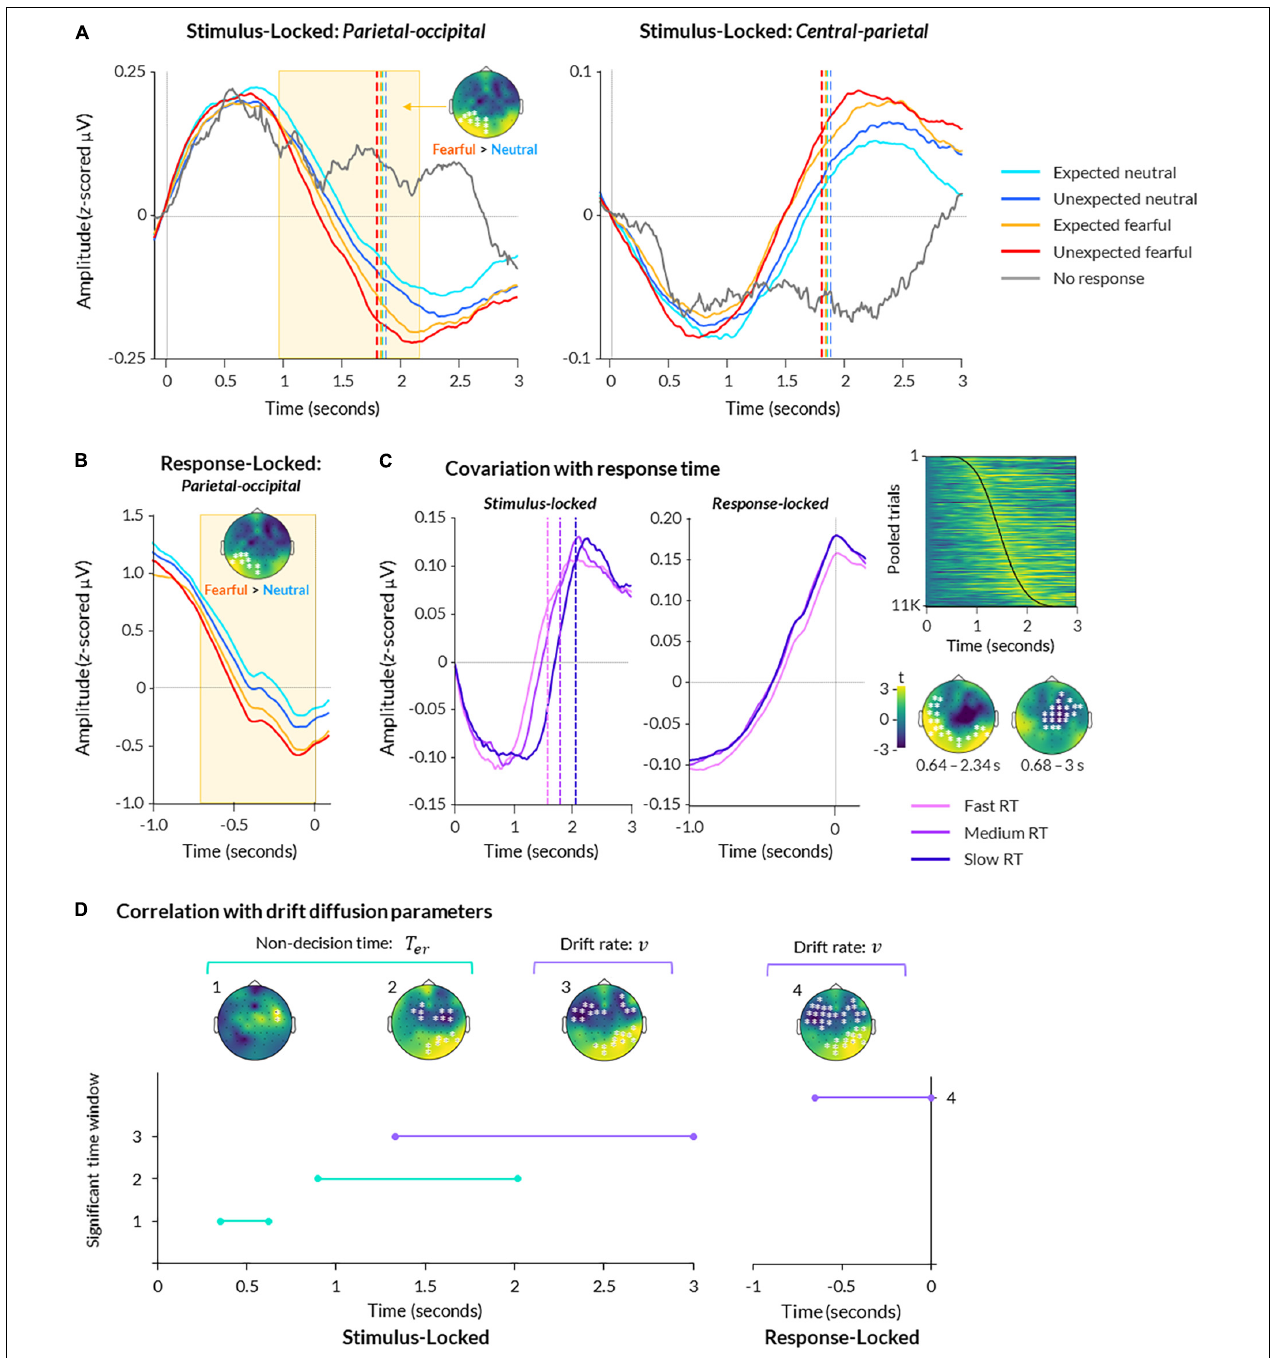
FIGURE 3 | Electroencephalography (EEG) activity during bCFS. (A) ERPs are displayed for parietal-occipital (left) and central (right) electrodes. Data are averaged across all subjects and presented for each condition, plus trials where no response was made. Data are time-locked to trial onset. Significant time-periods and scalp topography from a cluster-based permutation test are indicated for the effect of emotion (fearful > neutral; p < 0.05). (B) Same as (A) , except data is response-locked data from parietal-occipital electrodes. (C) Data from central-parietal electrodes are shown for stimulus-locked (left) and response-locked (middle) epochs, with trials split into fast, medium, and slow response times (using 25th, 50th, and 75th percentiles of each subject’s data, respectively). A heatmap (upper right) displays central-parietal neural amplitude from all trials pooled across all participants, sorted in order of response time with fastest at the top and slowest at the bottom (response times indicated by black line; heatmap was smoothed with a 2 FWHM Gaussian kernel for visualisation). Scalp topographies (lower right) show two significant clusters of activity covarying with response time at the group level ( p < 0.05). (D) A timeline of significant time windows for correlations between non-decision time (green lines) or drift rate (purple lines) and stimulus-locked (left graph) or response-locked (right graph) neural activity ( p < 0.05, FDR-corrected). Significant time windows are denoted numbers (y axis) corresponding to the topographies shown above.